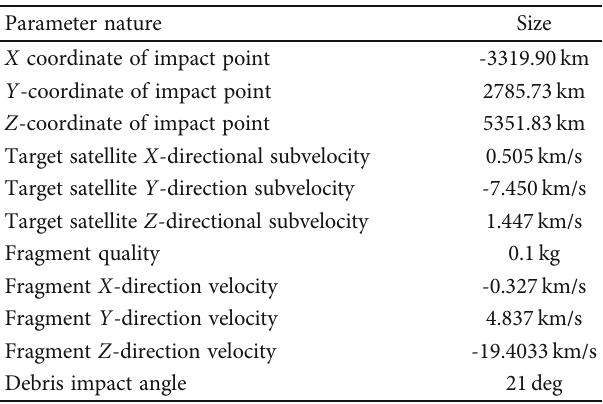
Table 1: Impact point